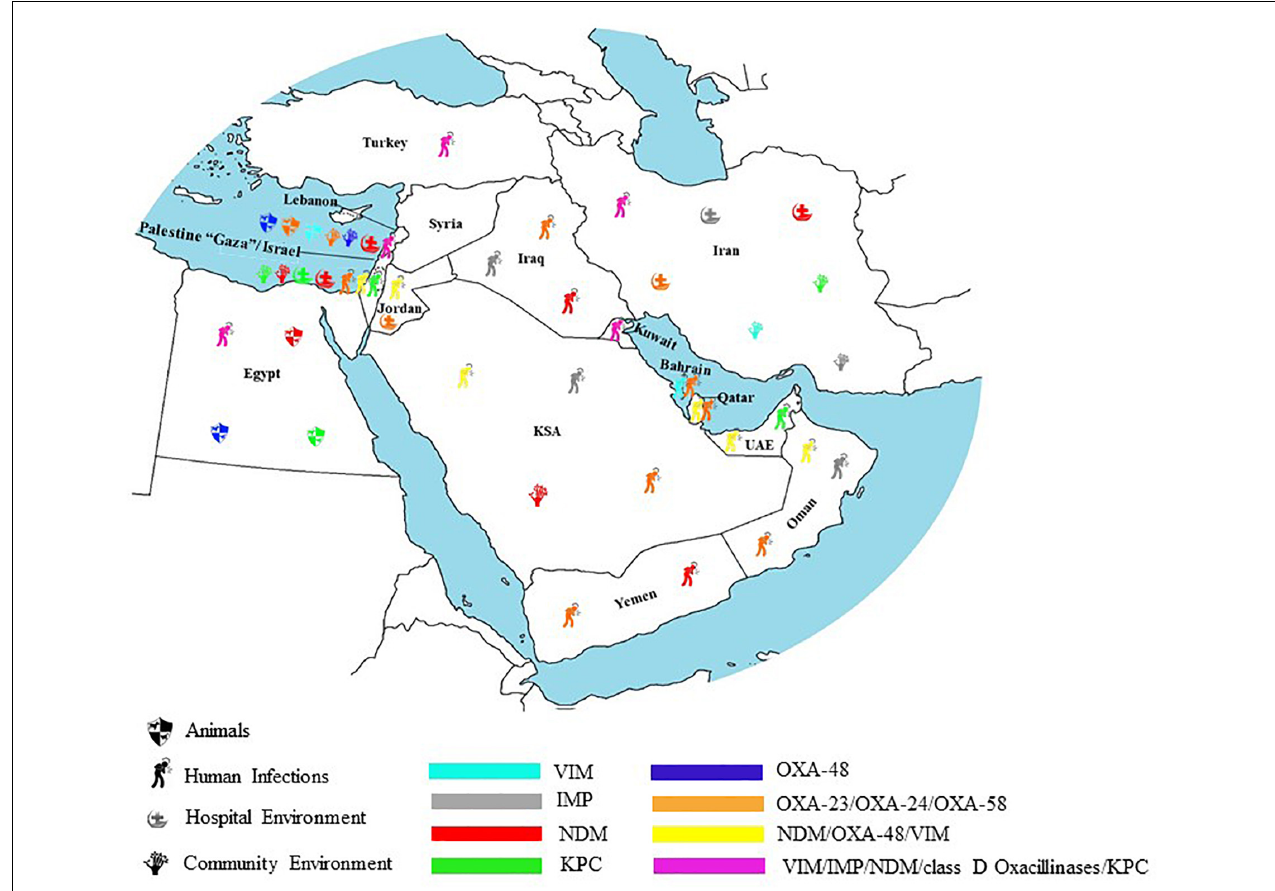
FIGURE 2 | Geographical distribution of carbapenemases in humans, animals, hospital, and community environment in the Middle East.